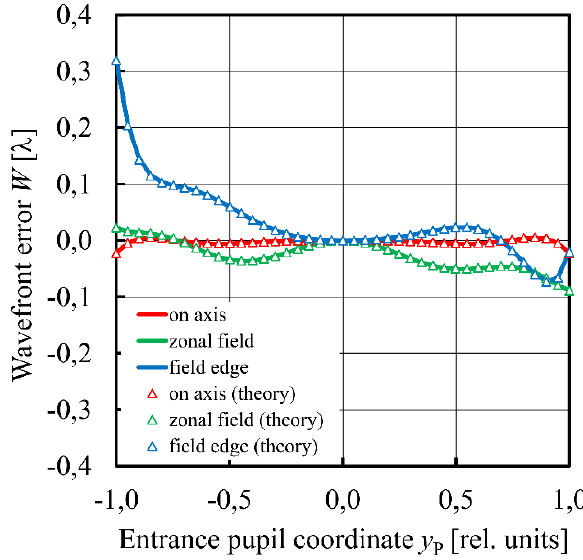
Fig. 5. Wavefront aberration W in meridional direction of the perturbed system given in Fig. 2(c) for three object heights h = 0.0 mm (on axis, red), h = 3.54 mm (zonal, green) and h = 5.0 mm (field edge, blue). Red, green and blue triangles indicate the theoretical prediction of the aberrations according to Eqn.